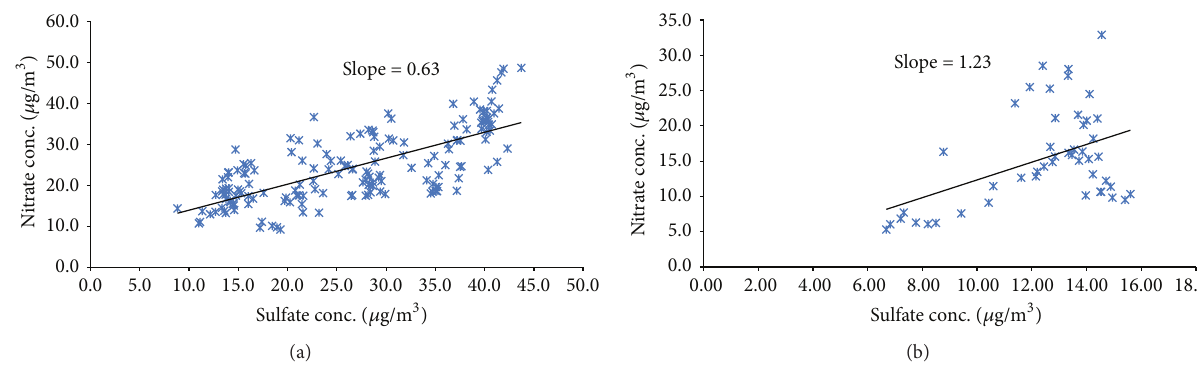
Figure 7: Correlation between sulfate and nitration concentration of (a) Case 1 and (b) Case 2 .